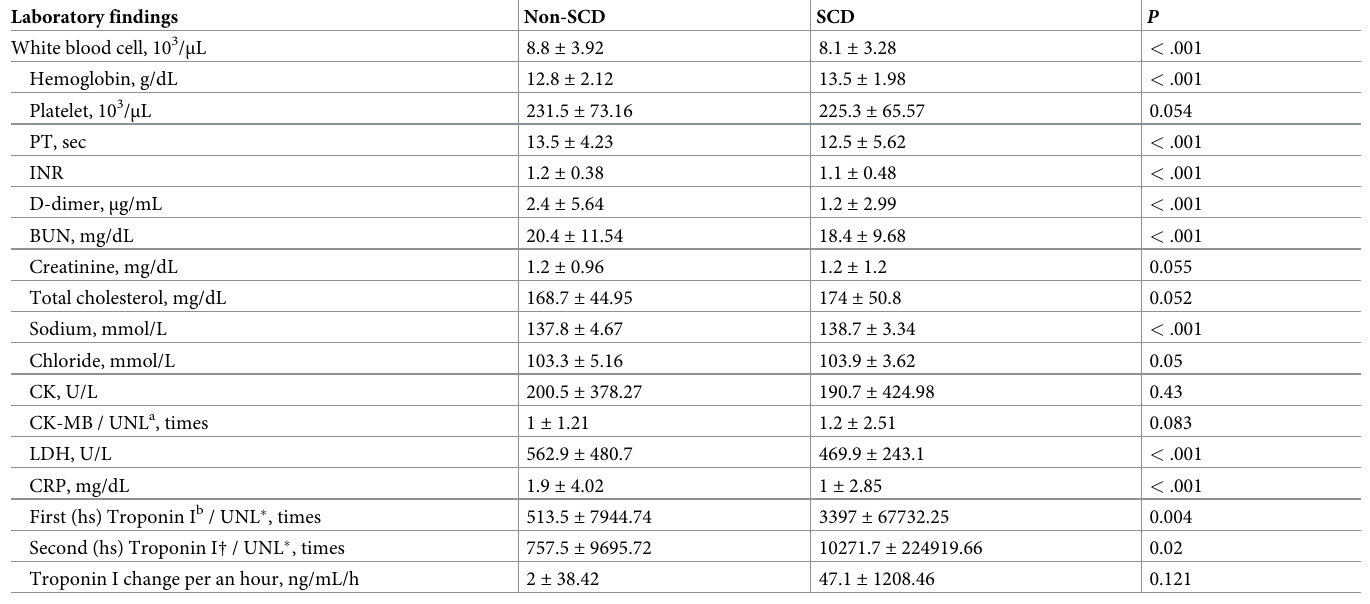
Table 2. Relation between coronary artery disorder and variables in laboratory